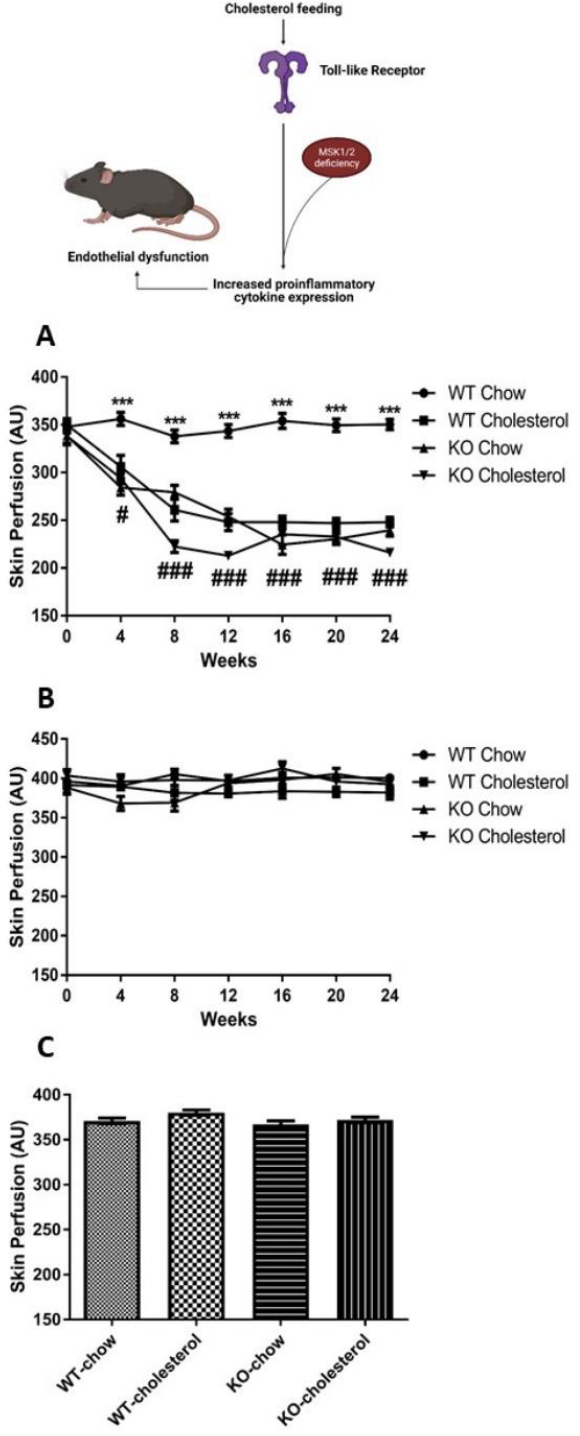
Figure 3. Microvascular responses in MSK1/2 knockout and wild-type mice. ( A ) Endothelial- dependent microvascular responses in arbitrary units (AU) over 24 weeks and ( B ) localized 44 ◦ C heating (over 24 weeks) and terminal endothelial-independent ( C ) in wild-type (WT)-chow ( n = 19), WT-cholesterol ( n = 19), MSK1/2 knock-out (KO)-chow ( n = 18) and MSK1/2 KO-cholesterol ( n = 18) fed animals. Longitudinal changes were analyzed by ANOVA for repeated measures followed by post-hoc Bonferroni correction. Values are group means ± SE. *** p < 0.001 comparing genotype responses between WT-chow and # p < 0.05, and ### p < 0.001, comparing diet with